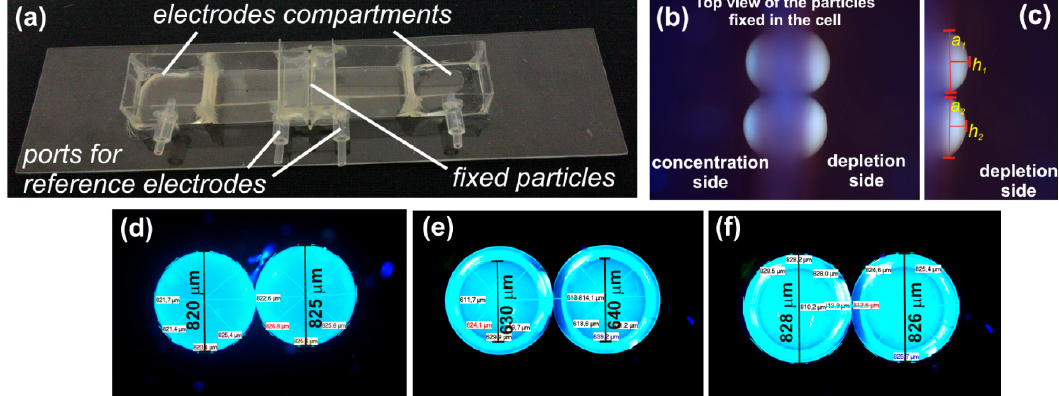
Figure 7. ( a ) Picture of the electrochemical cell used in the experiments; ( b ) picture of a two-particle system as seen under a microscope after it was fixed in the electrochemical cell and the particles were fully swollen; ( c ) detail of the swollen two-particle system on its depletion side. The depicted distances show how the surface areas used in calculating the current density were evaluated. The pictures (d) , (e) , and (f) show the top view of the two cation-exchange particles used in the preparation of the two-particle membrane system. Figure (f) depicts the two resin particles in the dry state before their embedding into the acrylic resin, figures (e) and (f) show dry resin particles after their embedding into the acrylic resin with corresponding measured distances.